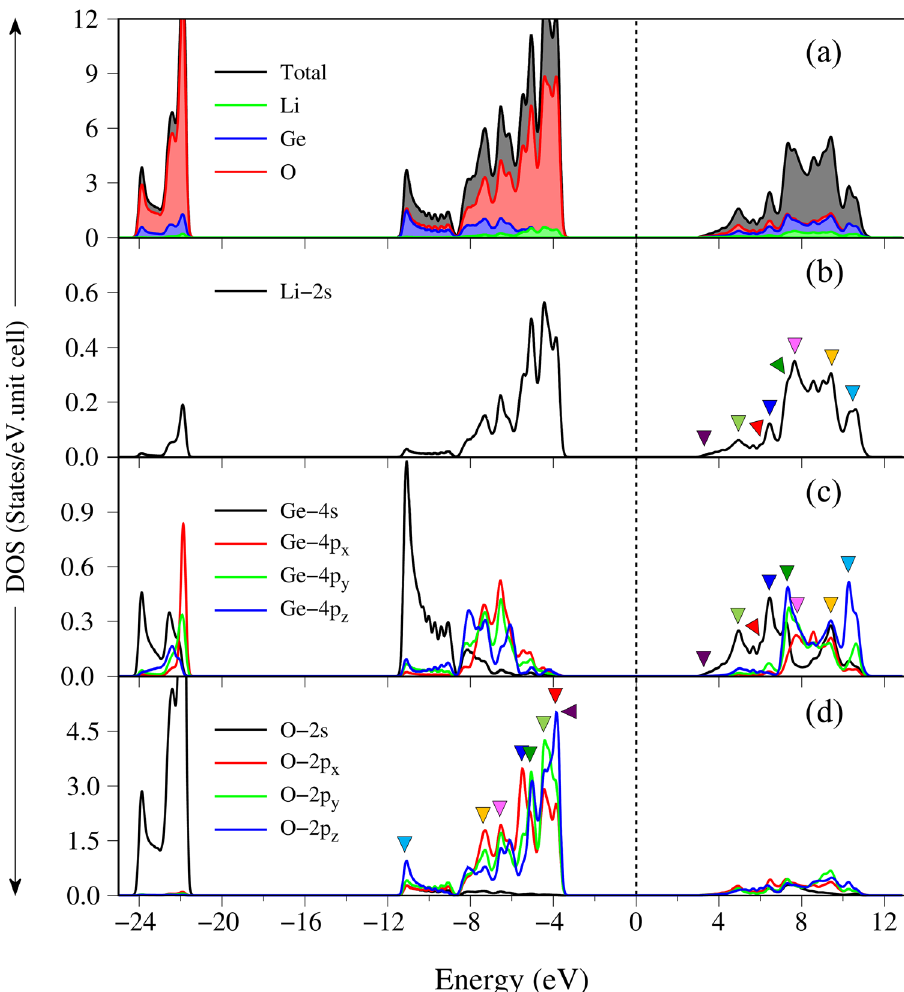
Figure 4. The G 0 W 0 quasi-particle density of states for different components: ( a ) total magnitude with Li-, Ge-, O-atom contributions, ( b ) Li-2s orbitals, ( c ) Ge-(4s, 4p x , 4p y , 4p z ) orbitals, and ( d ) O-(2s, 2p x , 2p y , 2p z ) orbitals. The colored triangles indicate the corresponding optical excitations, the dash line represents the Fermi